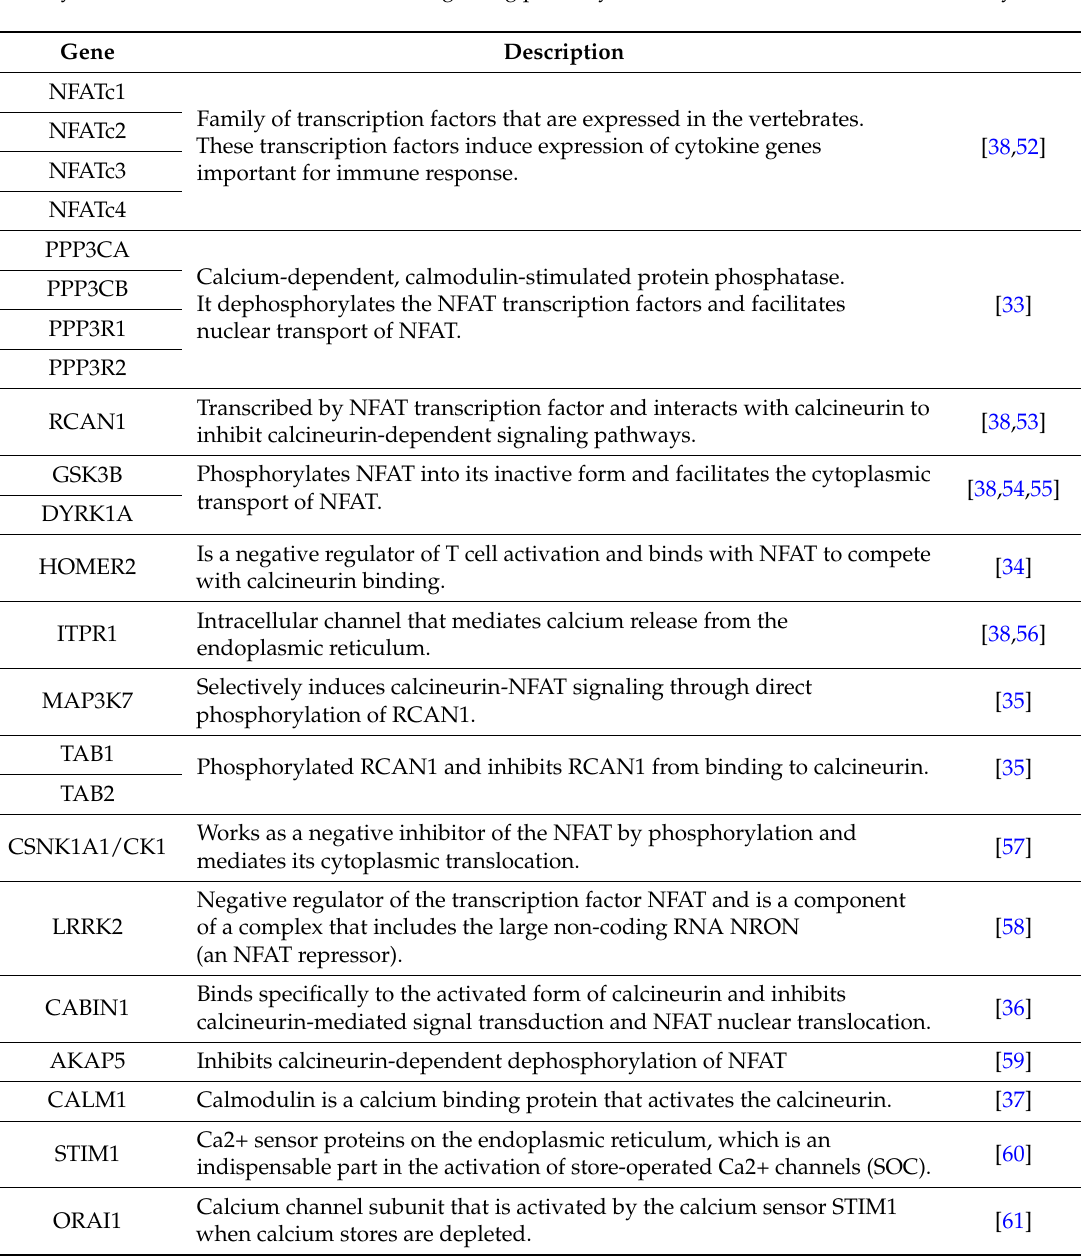
Table 1. Members of the calcineurin/NFAT signaling pathway analyzed in this study. Twenty-three key members of the calcineurin/NFAT signaling pathway were selected based on literature